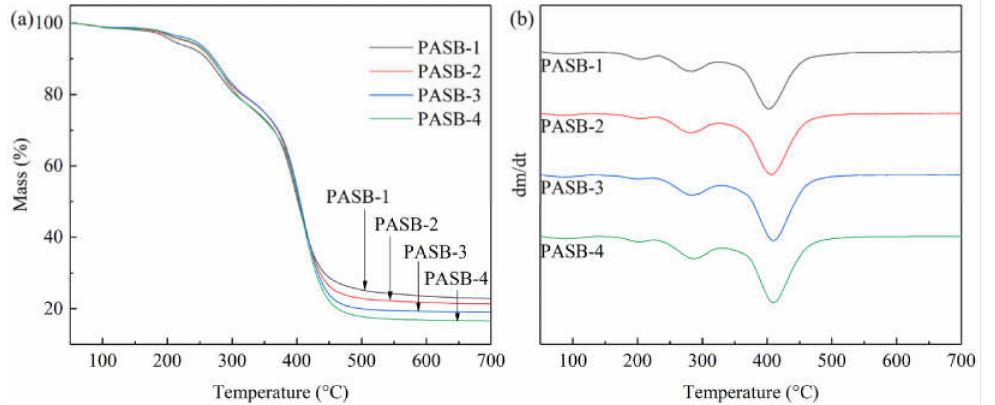
Figure 3. TGA and DTG curves of copolymers PASB. ( a ) TGA. ( b ) DTG.